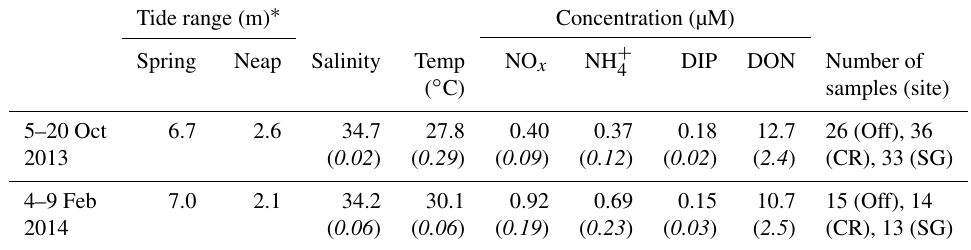
Table 1. Summary of mean (italics indicate standard deviation) conditions in offshore waters during October and February field experiments. Nutrient species measured are nitrate and nitrite (NO x ), ammonium (NH + ), dissolved inorganic phosphorus (DIP), and dissolved organic 4 nitrogen (DON). Number of duplicate nutrient samples collected is shown for offshore (Off), coral (CR), and seagrass (SG) sites.